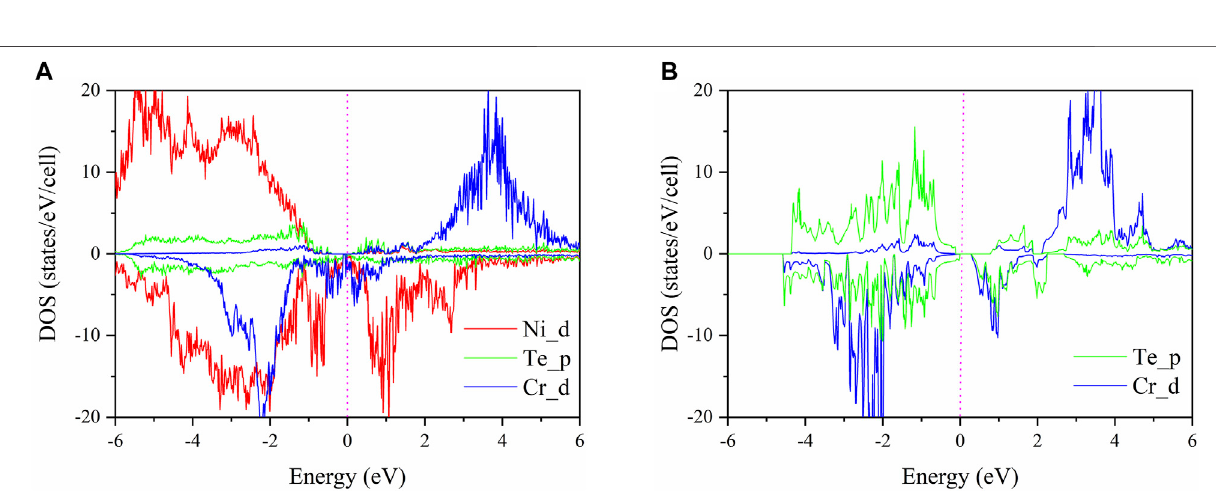
Frontiers in Materials |